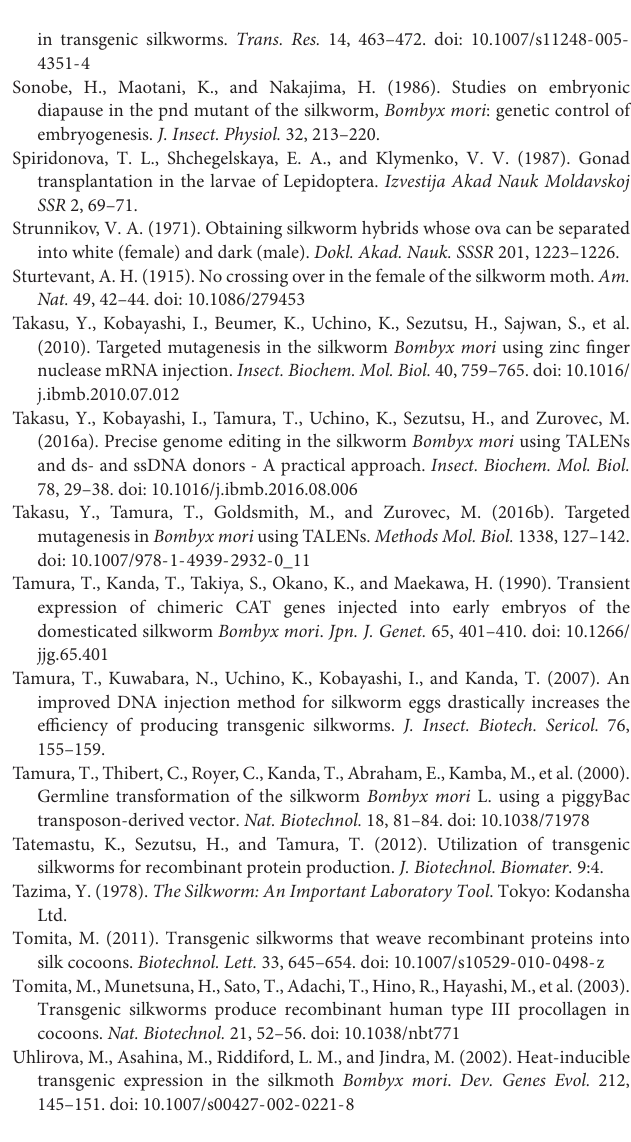
Supplementary Figure 1 | The nuclei in embryos of parthenogenetic PK1 strain incubated at 15 ◦ C 24 h after egg activation stained by propidium iodide (red) and by DAPI (blue). Scale bars: 500 µ